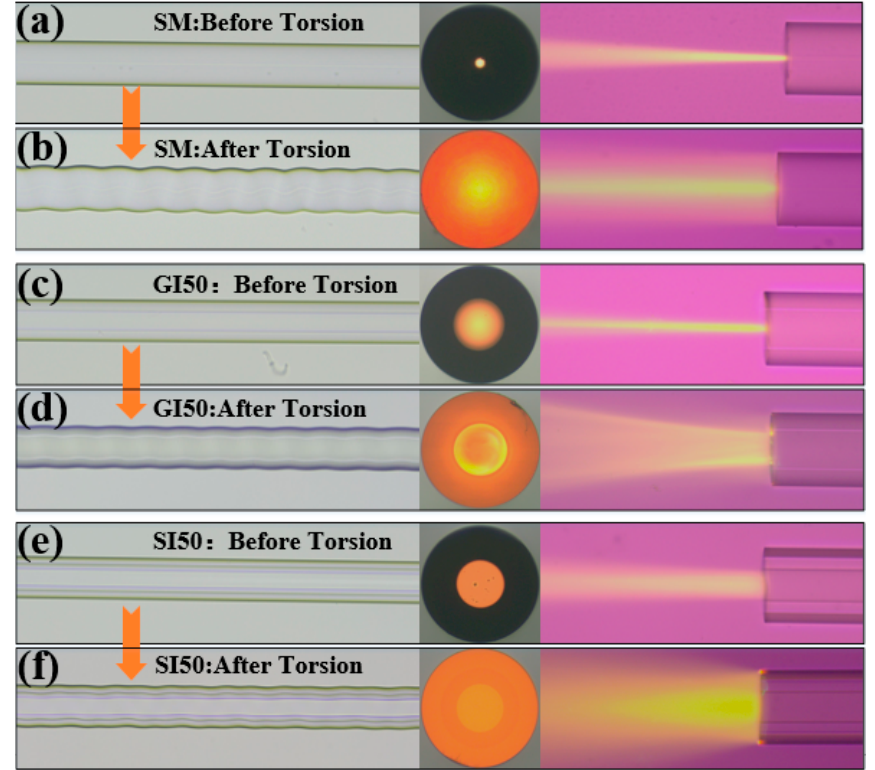
Figure 3. Microscopic physical photos, end face, and side emitted light field photos of different types of straight and twisted optical fibers: ( a ) single-mode straight fiber; ( b ) single-mode twisted fiber; ( c ) graded index multimode straight fiber; ( d ) graded index multimode twisted fiber; ( e ) step-index multimode straight fiber; ( f ) step-index multimode twisted fiber.